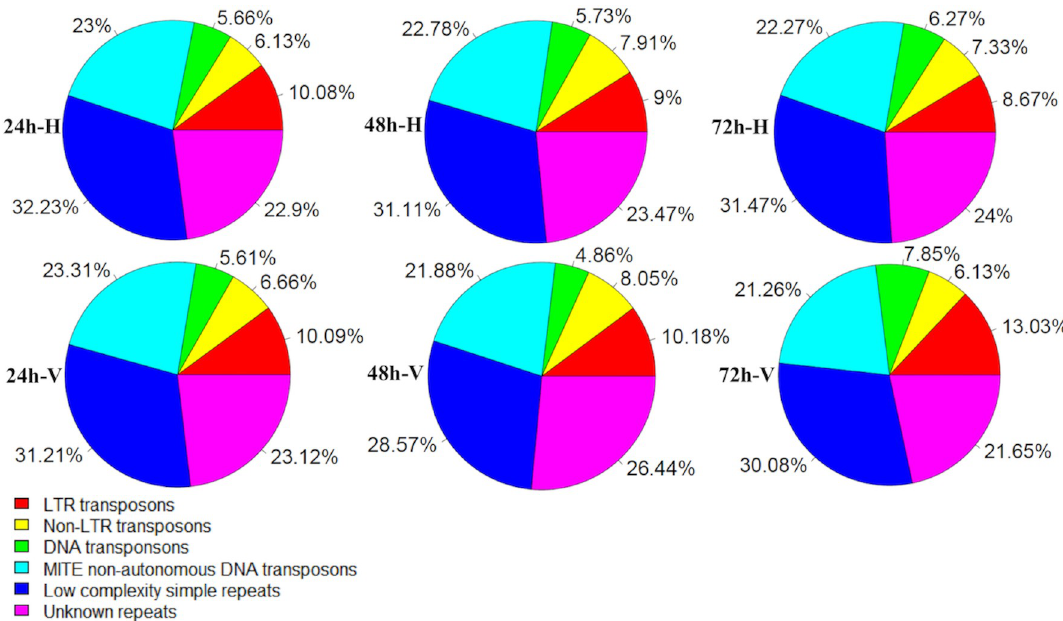
Fig 2. Distribution of repeat elements in piRNA clusters. Different color denotes different families of transposable elements. It shows the percentage of specific repeat family present at specific time points after whiteflies fed on uninfected/TYLCV-infected tomato. 24 h-H, 48 h-H, and 72 h-H represents whiteflies fed on uninfected tomato for 24, 48 and 72 hours, respectively. 24 h-V, 48 h- V, and 72 h-V represents whiteflies fed on TYLCV-infected tomato for 24, 48 and 72 hours, respectively.